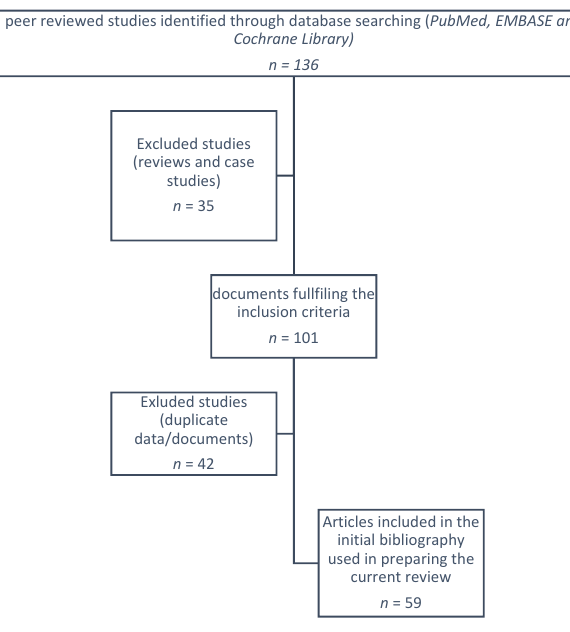
Figure 1. Flow chart of database searching .